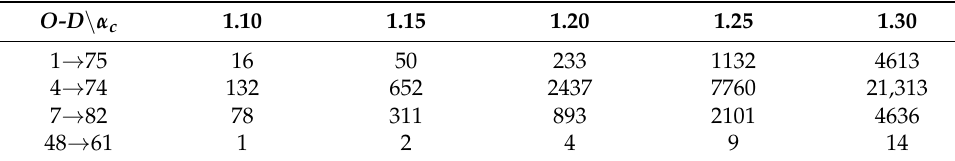
Figure 4. Test network of Coloane-Taipa area. Table 7. The number of alternative